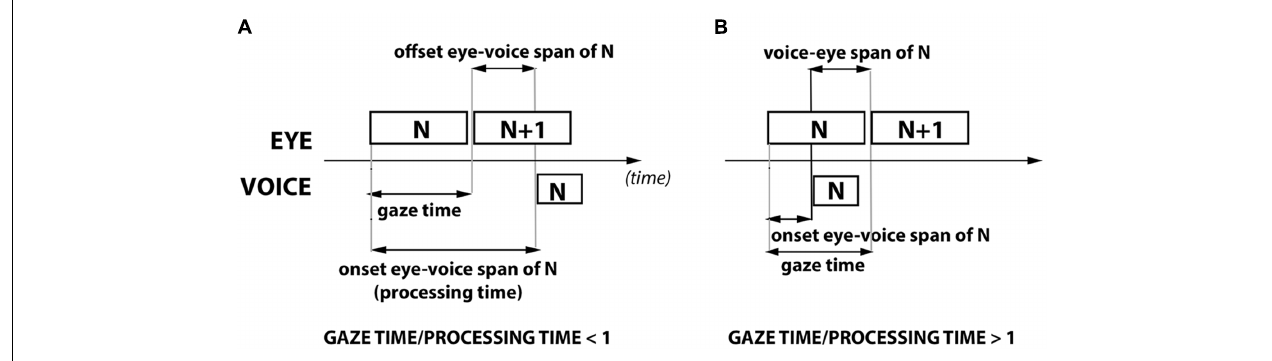
FIGURE 1 | Eye-Voice measures under two possible circumstances: (A) naming of N occurs while the reader views N + 1 (Eye-Voice Span) and (B) Naming of N occurs while the reader is still viewing N (Voice-Eye Span). See text for more details (GT/PT, Gaze Time/Processing